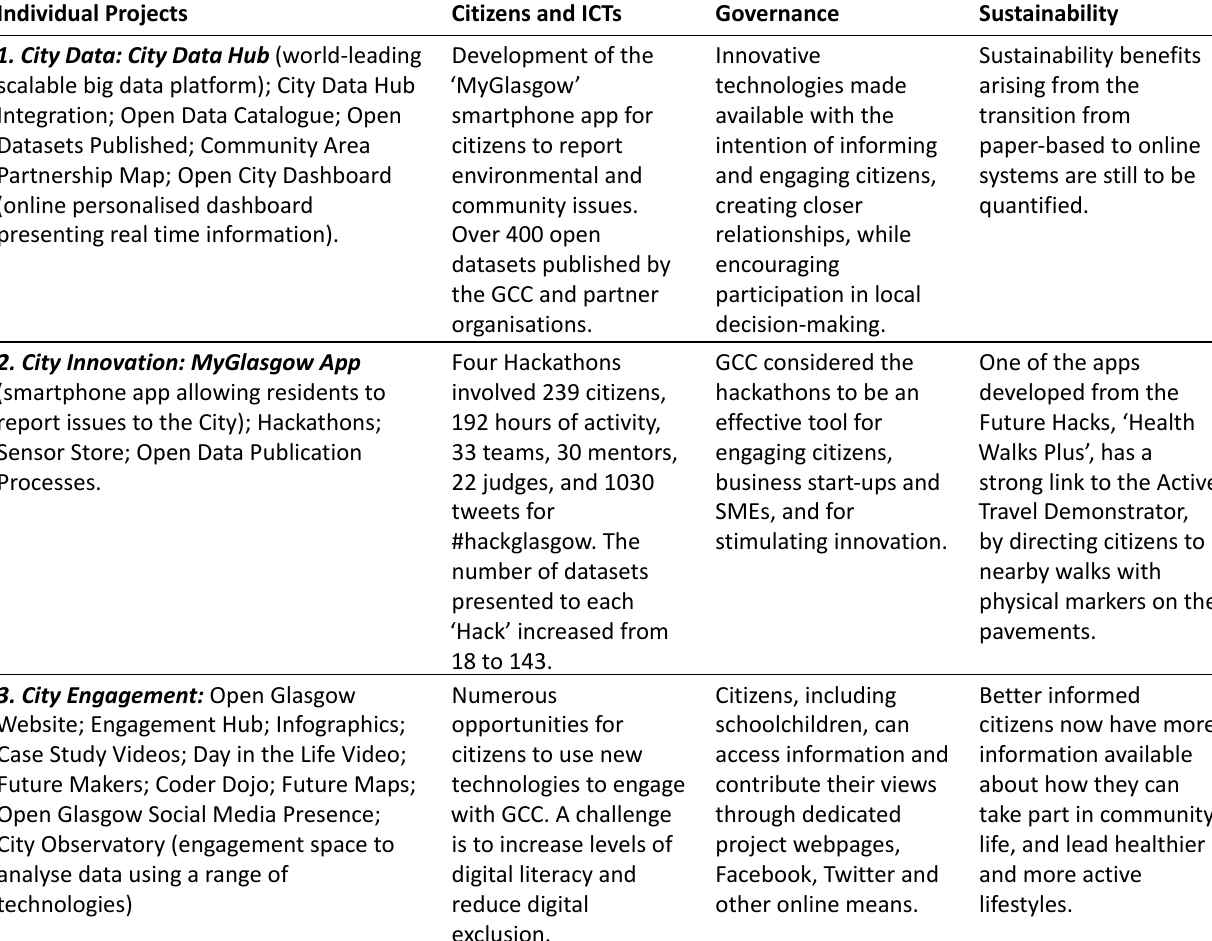
Table 5. Connected Glasgow. Individual